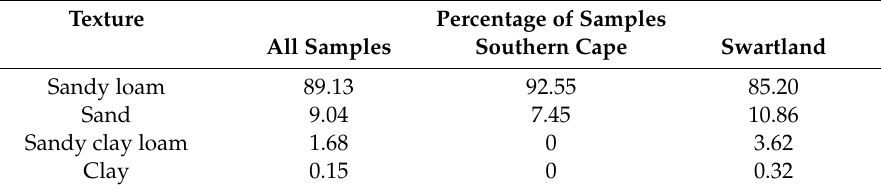
Table 4. Percentage of soil samples per texture